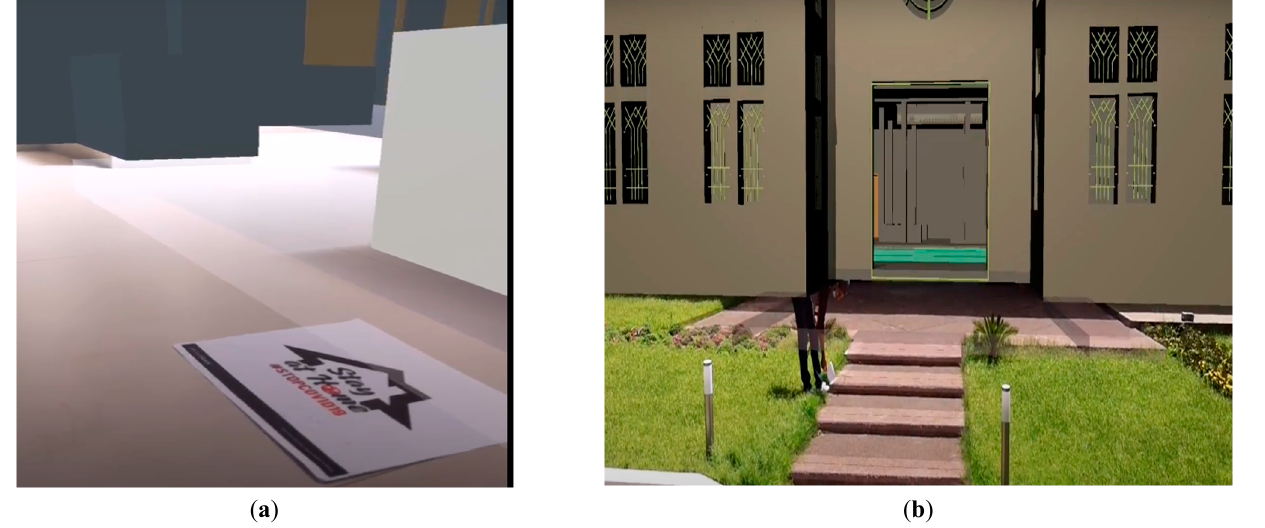
Figure 15. ( a ) Augmentation of a single model entity (beam). ( b ) Augmentation of the whole building by the marker-based method.